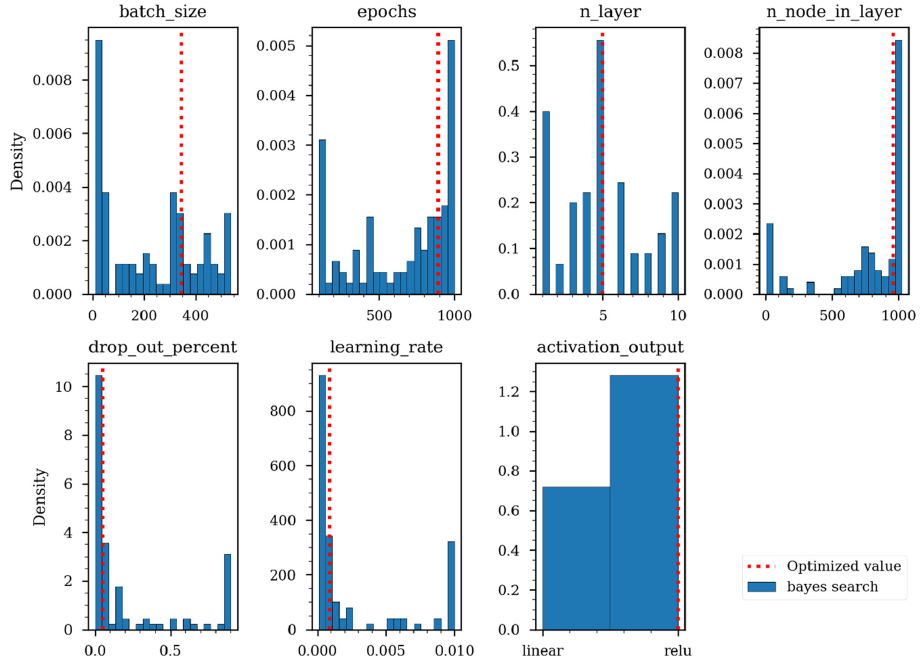
Figure 13. Probabilistic density histograms of sample space for neural network regression with Bayesian search compared with the estimated optimal hyperparameter.